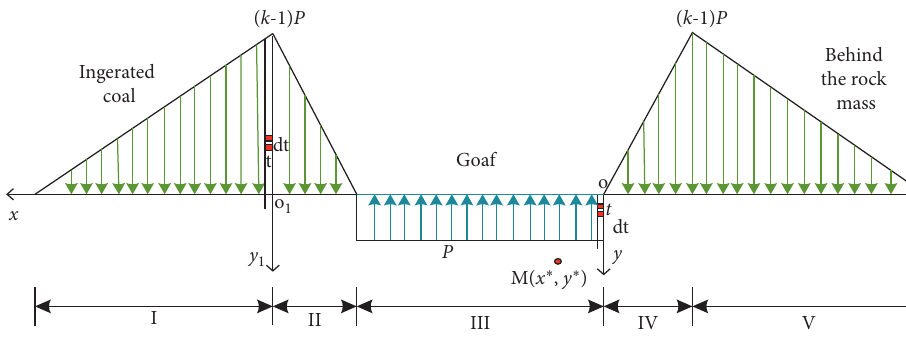
Figure 4: Diagram of stress increment